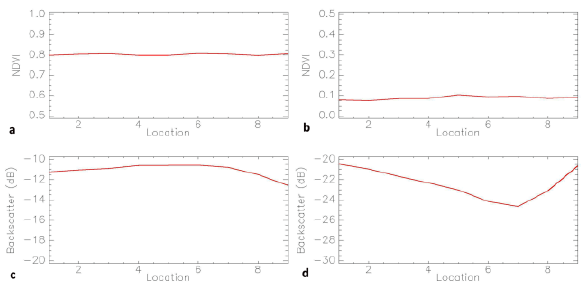
Figure 9. Spectral profiles of the profile marked in red. (a) 2016 NDVI (b) 2019 NDVI (c) 2016 backscatter (d) 2019 backscatter.